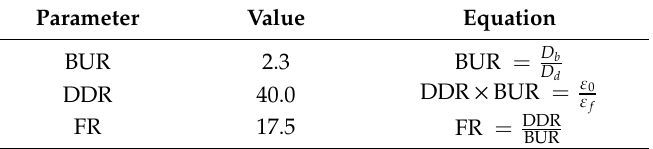
Table 2. Processing parameters of the blown film production and the equations. Parameter